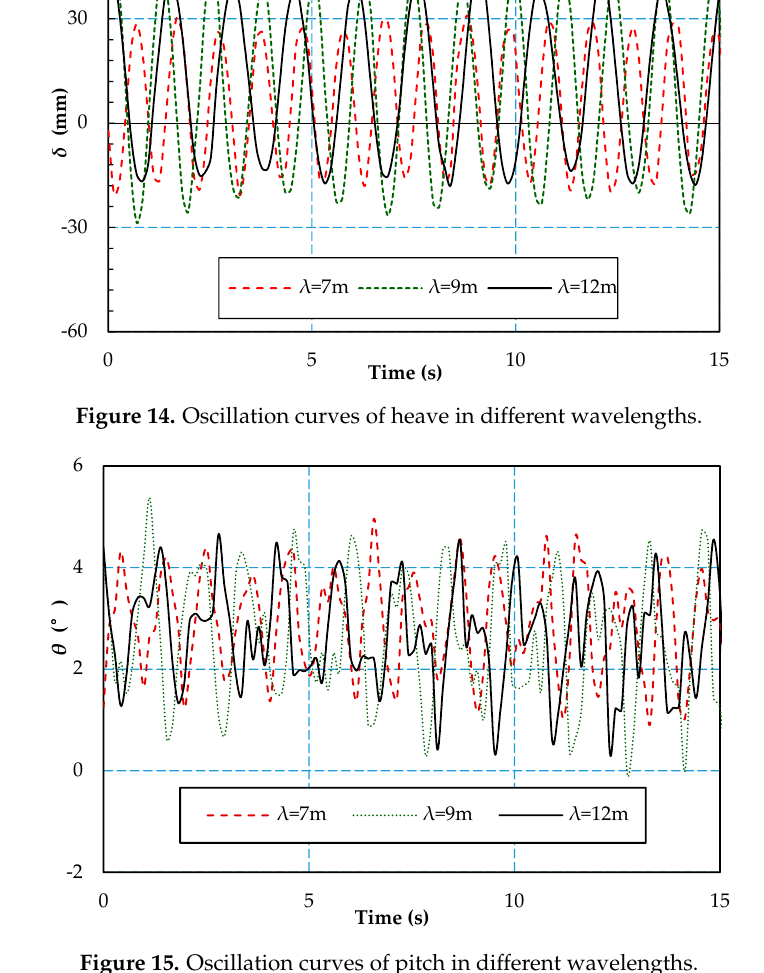
Figure 15. Oscillation curves of pitch in different wavelengths.